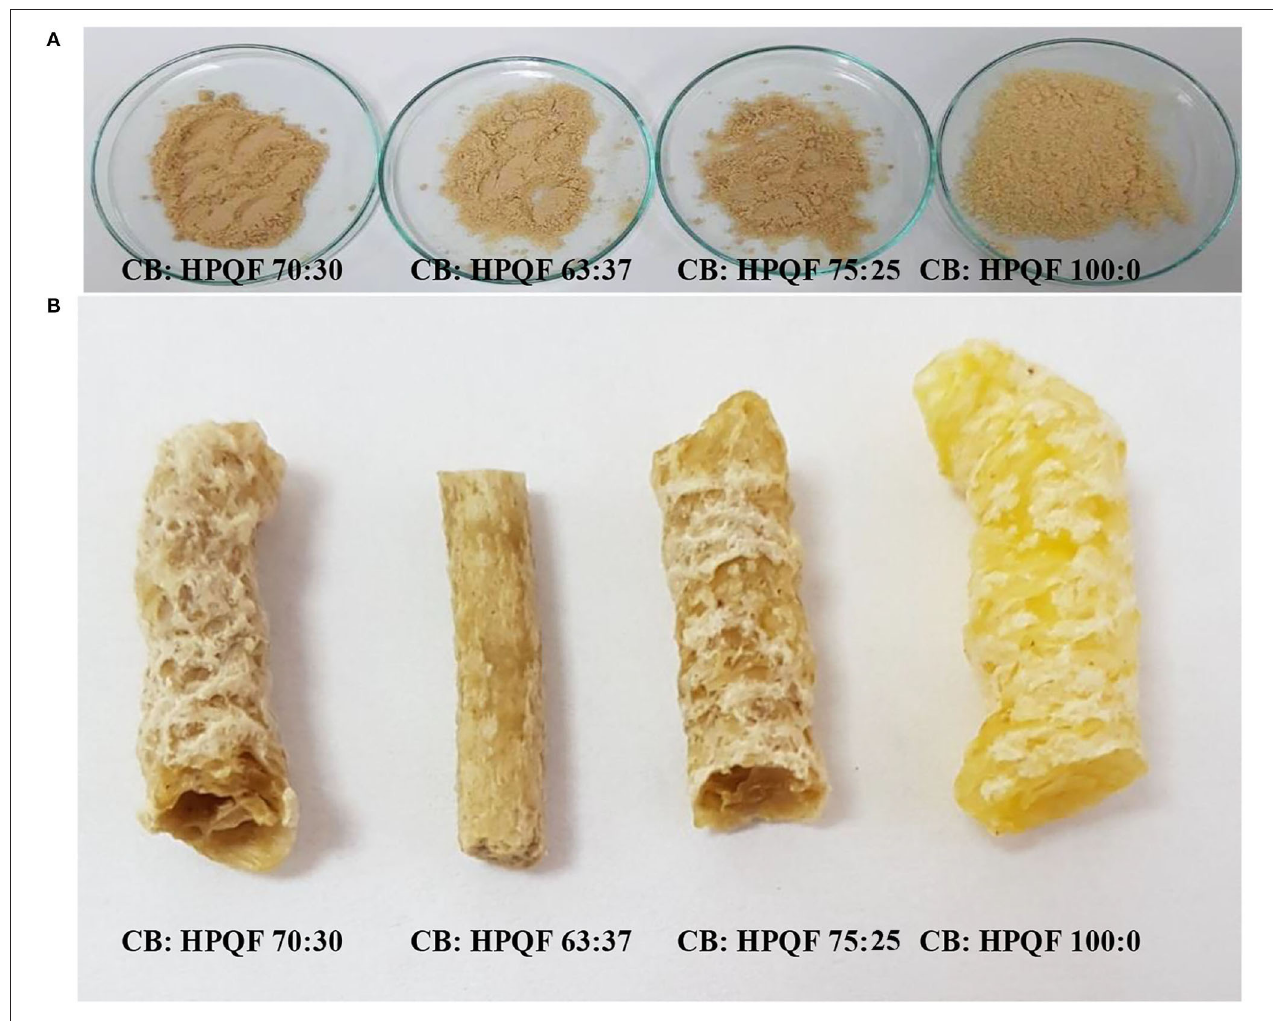
FIGURE 2 | Digital image of non-extruded up (A) and extruded flours of cereal mixes from hyper-protein quinoa flour down (B) .